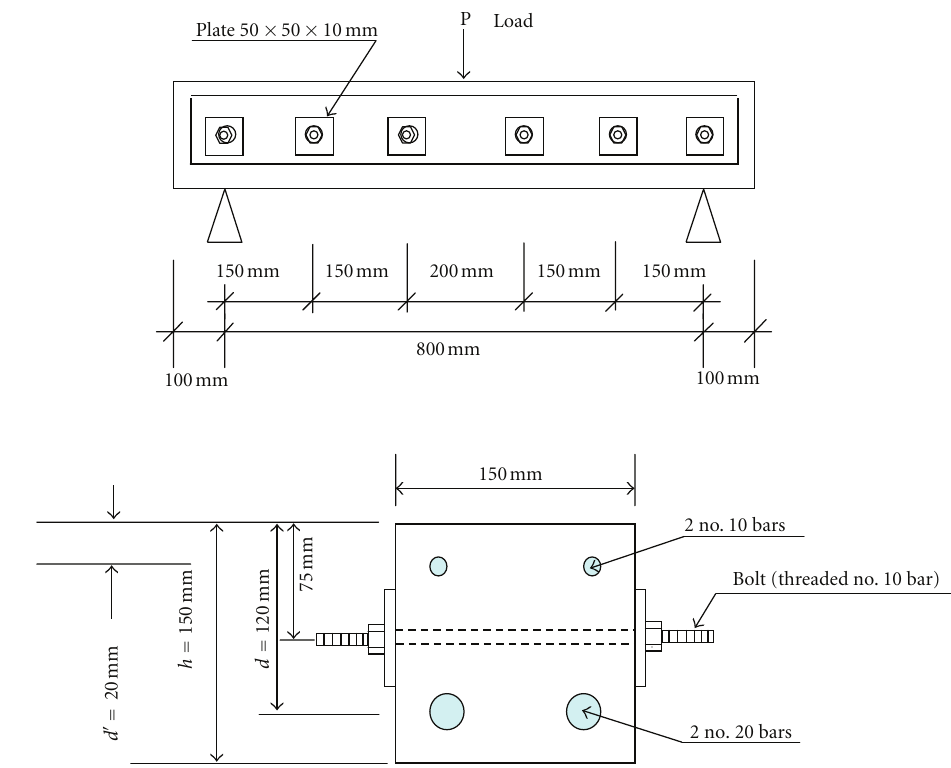
Figure 9: Cross-sectional details of RC beam C-NS-6B.